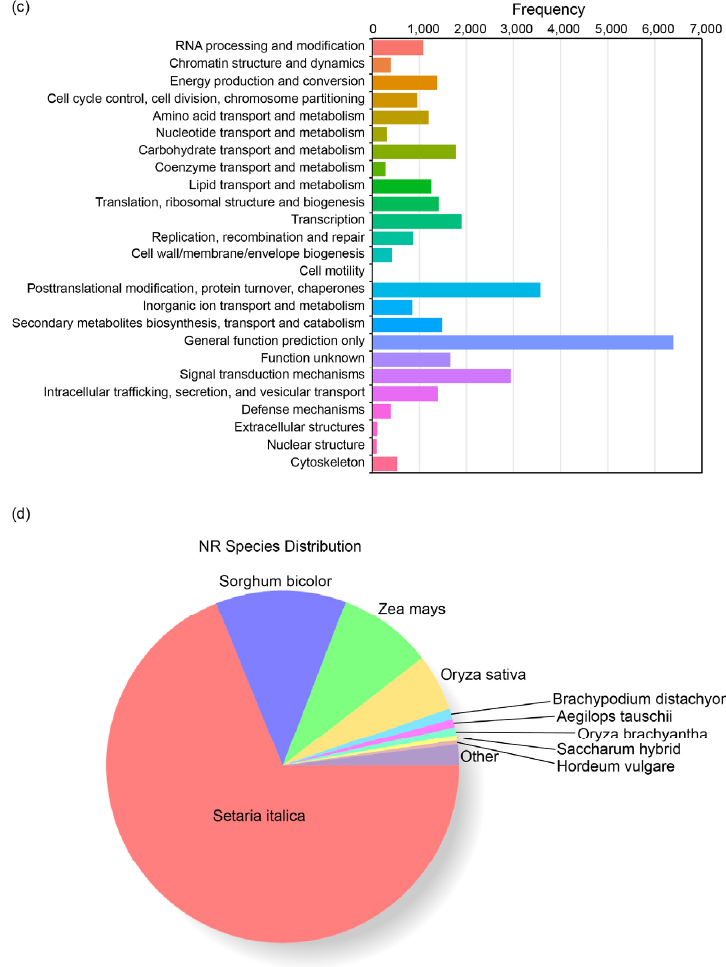
Figure 1. GO, KOG, NR, and KEGG annotation. ( a ) GO annotation to demonstrate the possible functional classifications of broomcorn millet genes. The lighter bars correspond to all genes (black), and the darker bars to differentially expressed genes (DEGs, blue). The genes were categorized into three main types: “biological process”, “cellular component”, and “molecular function”. ( b ) KEGG annotation showed that most of the genes were in the metabolism category. The genes were grouped into “cellular process”, “genetic information processing”, “organismal systems”, “metabolism”, and “environmental information processing”. ( c ) KOG annotation grouped all genes into 25 functional classifications. The number of genes annotated for this function and the percentage of total genes are shown in square brackets. ( d ) nr annotation showed that most of the sequenced broomcorn millet genes are highly similar to corresponding genes in Setaria italica and Sorghum bicolor